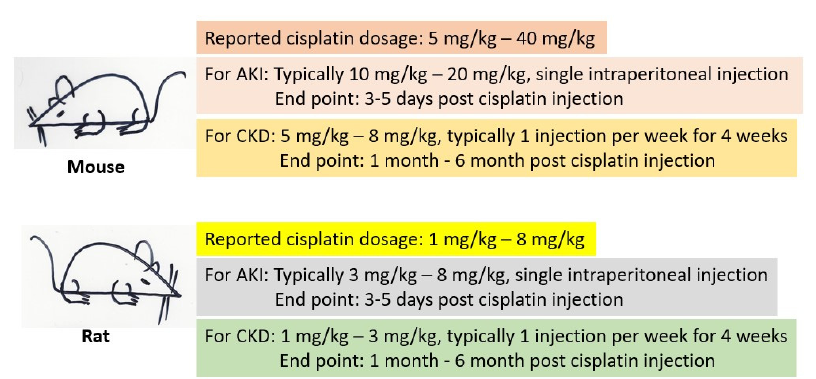
Figure 3. Outlines of rodent models used for studying cisplatin-induced kidney injury. Shown are the dose ranges for either mice or rats involving either AKI or CKD. It should be noted that these are just general guidelines for designing an experiment and should be modified for specific experimental objectives if needed.